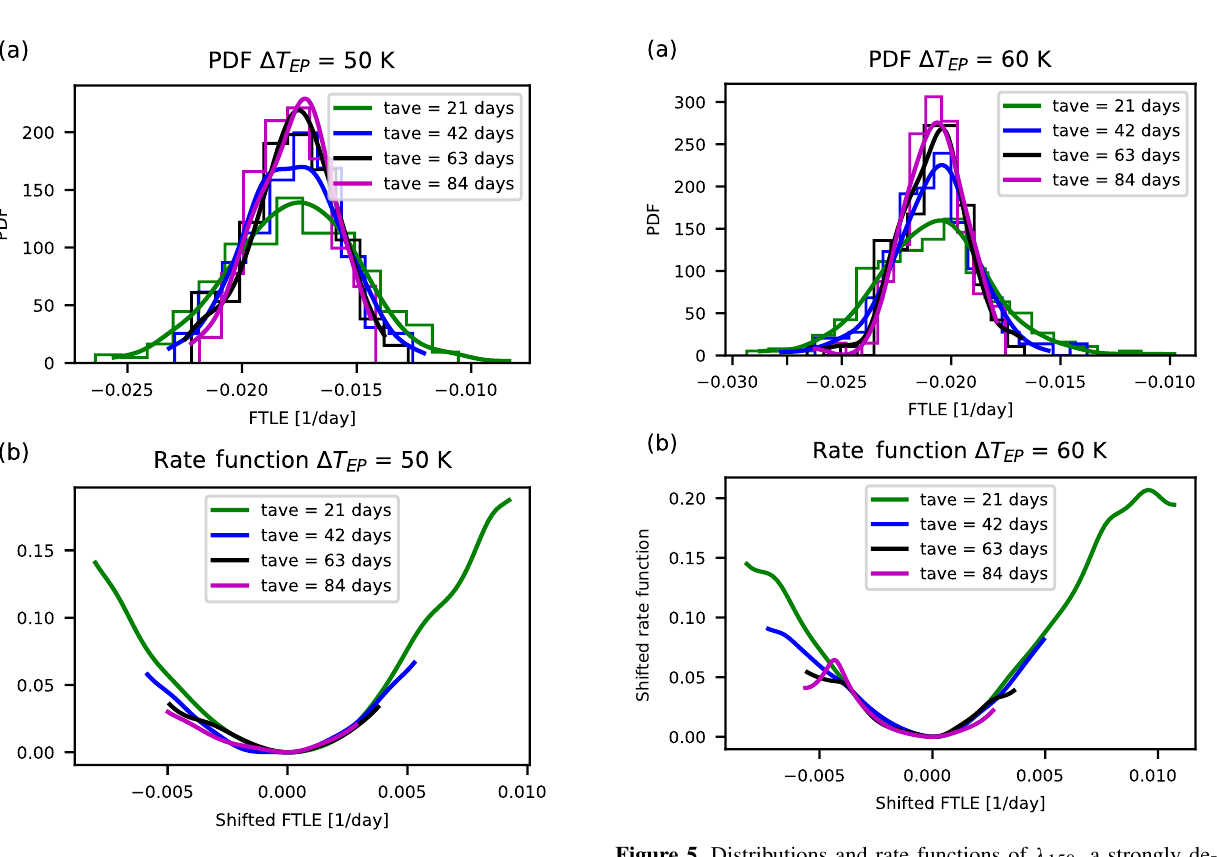
Figure 4. Distributions and rate functions of λ 150 , a strongly de- caying direction in PUMA, for (cid:49)T EP = 50K. Panels as in Fig. 2.